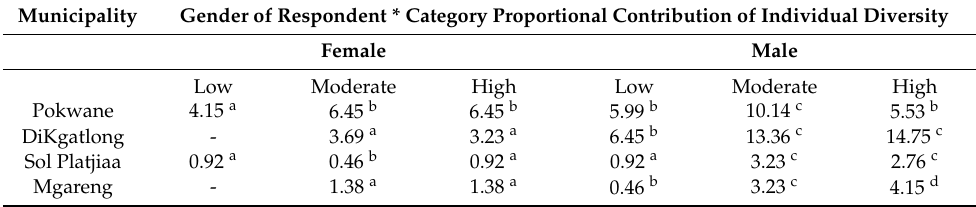
Table 3. Distribution of diversity as a % in the four municipalities according to